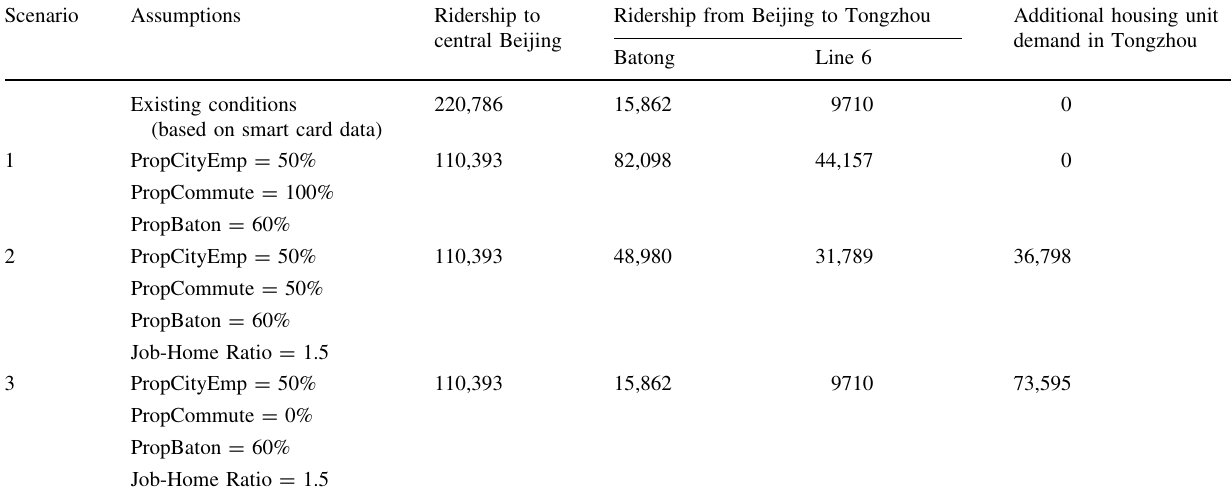
Table 1 Morning rush hour ridership on subway from Beijing to Tongzhou under different scenarios Scenario